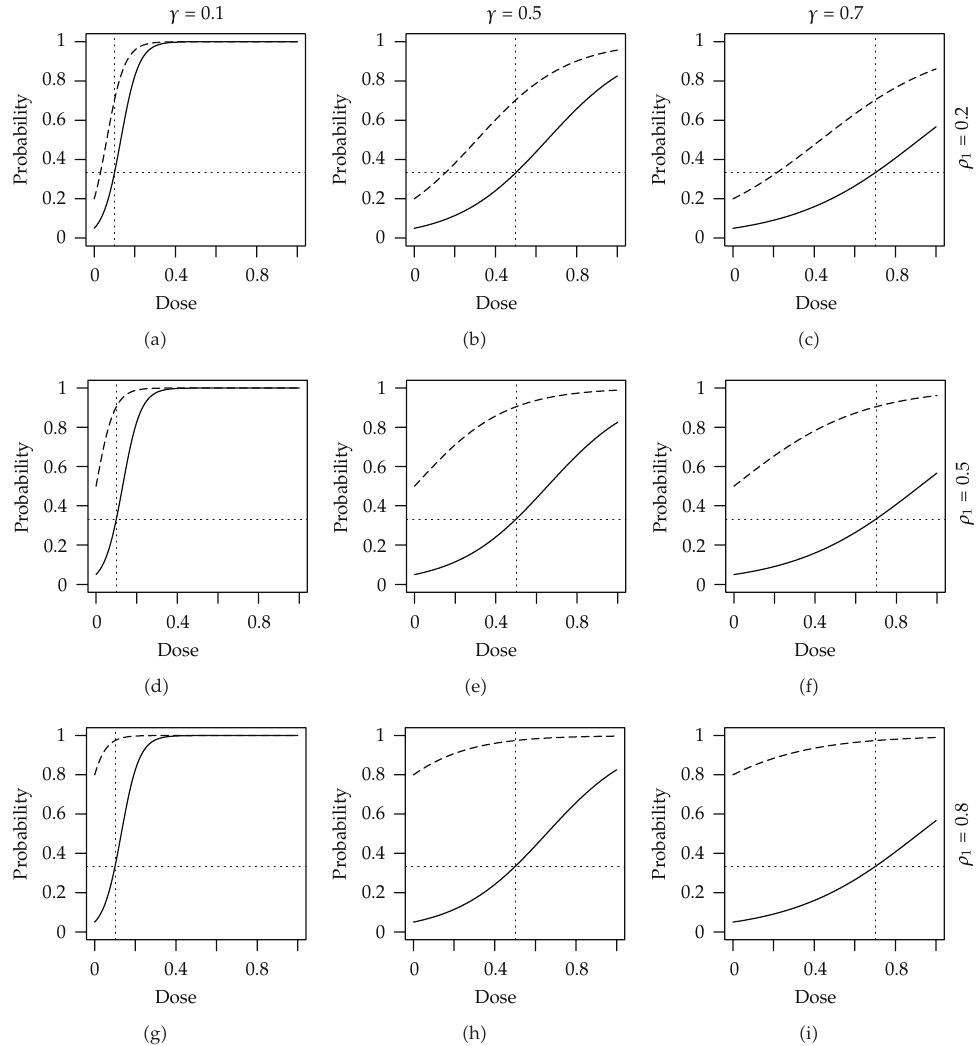
Figure 2: Dose-toxicity relationship for the nine scenarios considered in the design operations characteris- tics. The solid curves correspond to P (cid:2) Y (cid:7) 2 | x (cid:3) (cid:7) P (cid:2) DLT | x (cid:3) and the dashed curves in bold correspond to P (cid:2) Y > 1 | x (cid:3) . The horizontal dashed lines represent the target probability of DLT θ (cid:7) 0 . 33 and the vertical lines correspond to the true values of the MTD γ